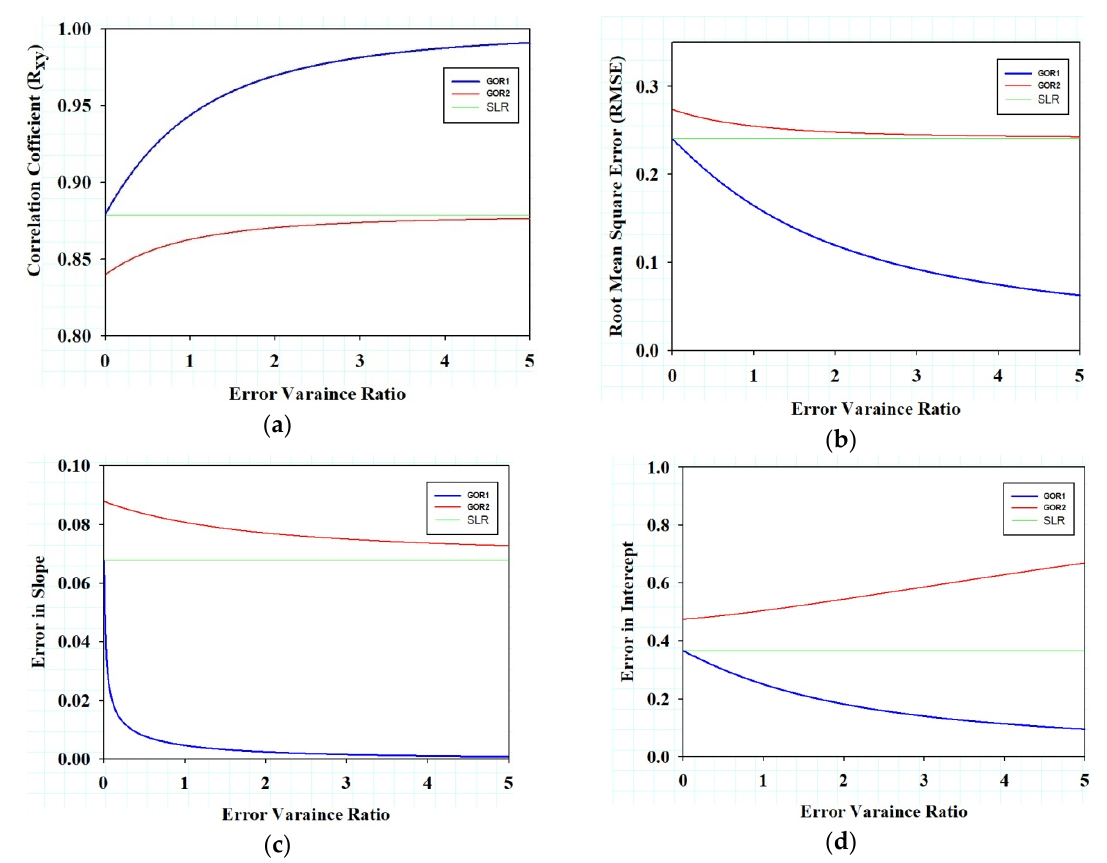
Figure 12. Comparison of the uncertainty in regression parameters for (M L – M wg ) data pairs using GOR1, GOR2, and SLR approaches considering function of error variance ratio: ( a ) Correlation Coefficient determination (R xy ), ( b ) Root mean square error (RMSE), ( c ) uncertainty values of slope and ( d ) uncertainty of intercept.